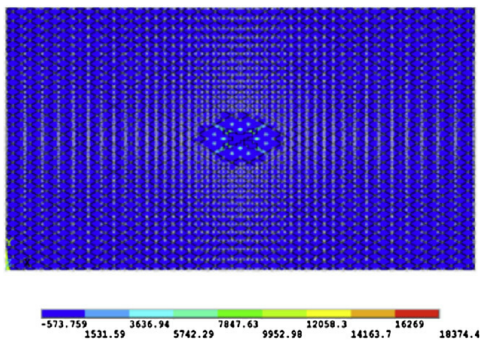
Figure 13. The ablation extension of rhombic braided copper mesh.